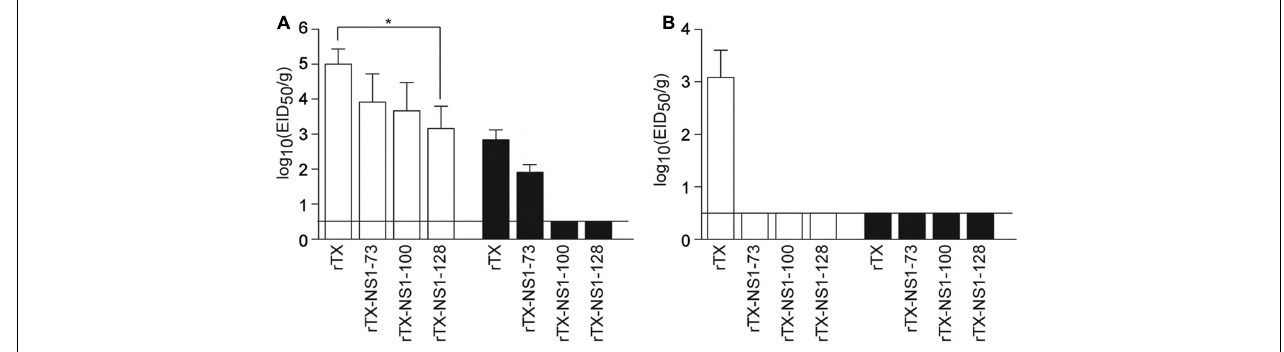
FIGURE 3 | Pathogenicity in chickens. (A) Replication of WT and NS mutant viruses in chicken tracheal tissues. (B) Replication of WT and NS mutant viruses in chicken lung tissues. Chickens were intranasally infected with 10 6 EID 50 /0.2 ml of rTX or each NS mutant virus; three infected chickens were sacrificed on 3 (open bars) and 5 (closed bars) days post-inoculation (dpi) to collect tissue samples. All tissue samples were titrated for viral infectivity using EID 50 assays. The mean and standard errors are shown. Asterisk represent p -values < 0.05. Horizontal bar indicates the limit of